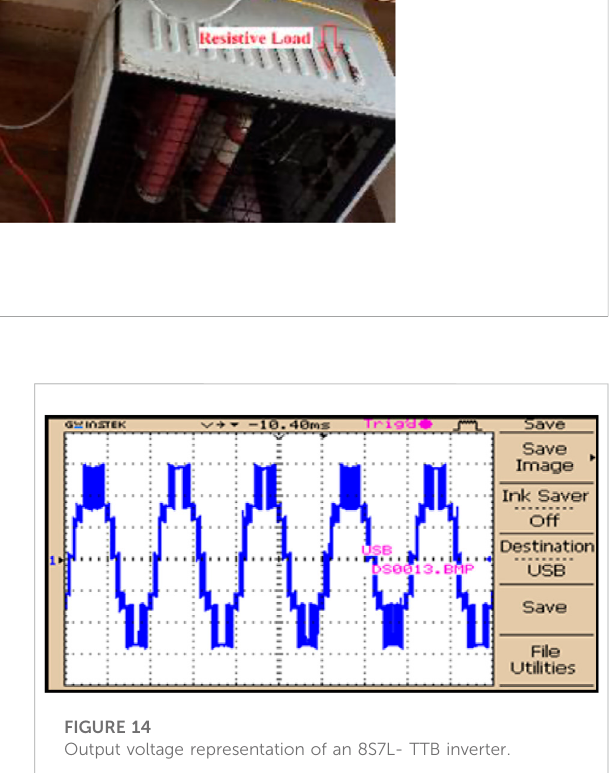
FIGURE 13 Voltage representation of the PV system.